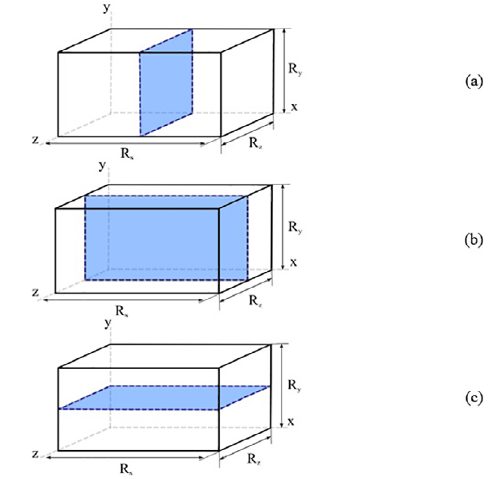
Figure 6. Cartesian planes used to analyze the concentration of free and entrapped solute inside the composite.